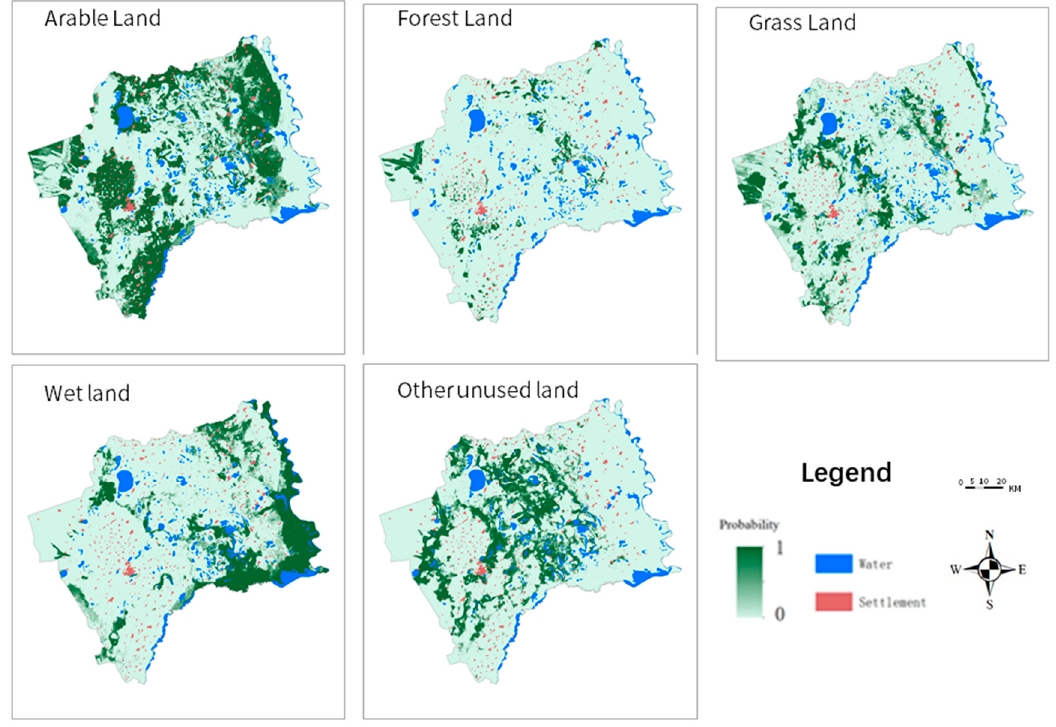
Figure 9. Probability maps.